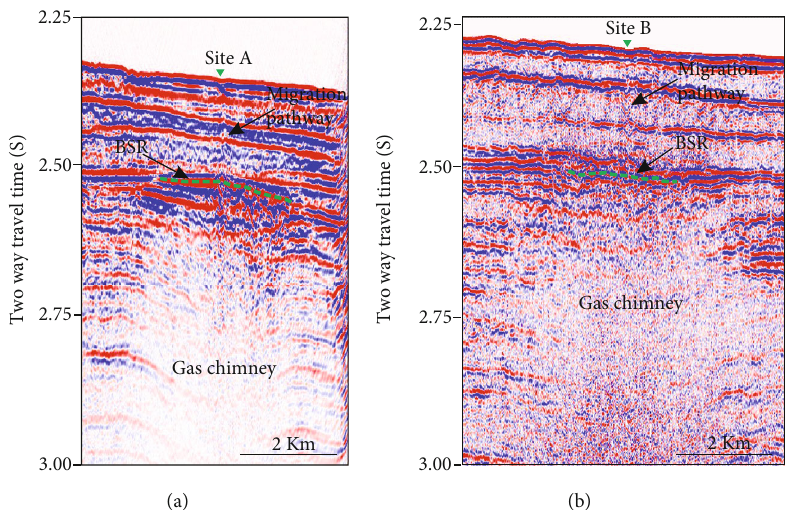
Figure 7: Seismic pro fi les of stations A and B. (a) Evident gas chimney and a migration pathway blocked by the formation of gas hydrate. (b) Deep gas chimney directly connecting the sea fl oor with a fl uid migration